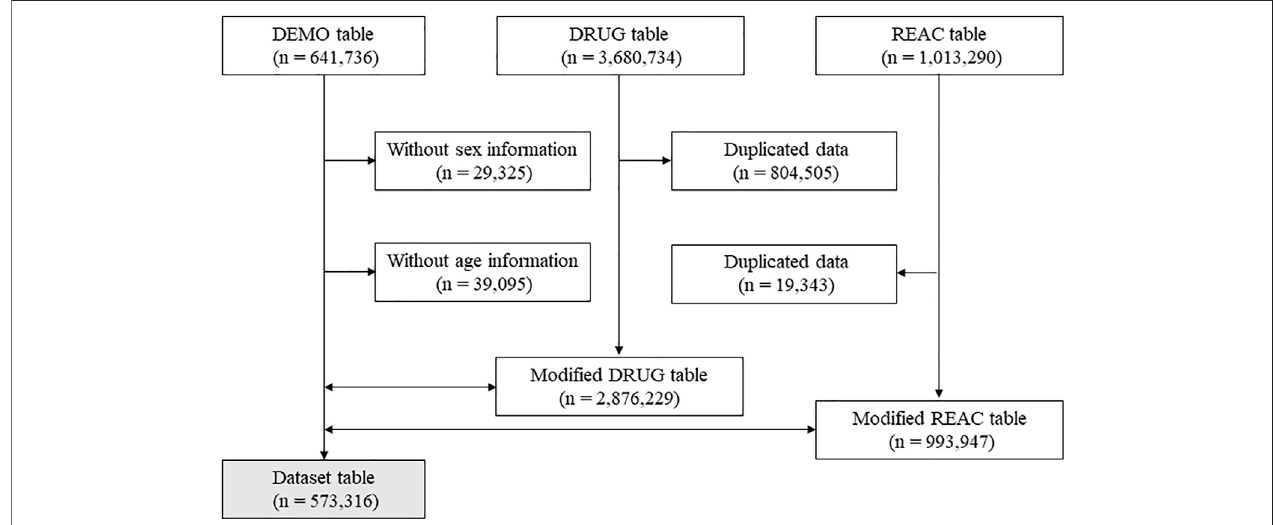
FIGURE 1 | Flow diagram of the study. Dotted arrow and double arrow show data exclusion and combination, respectively.